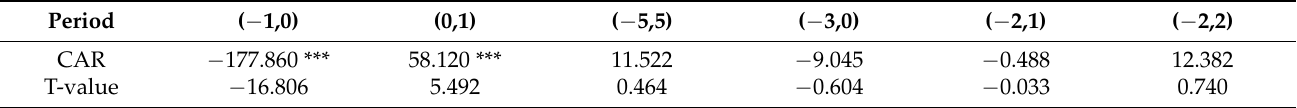
Table 3. Analysis of window periods of CAR of IC design houses in patent lawsuits. Unit: Percentage (%).